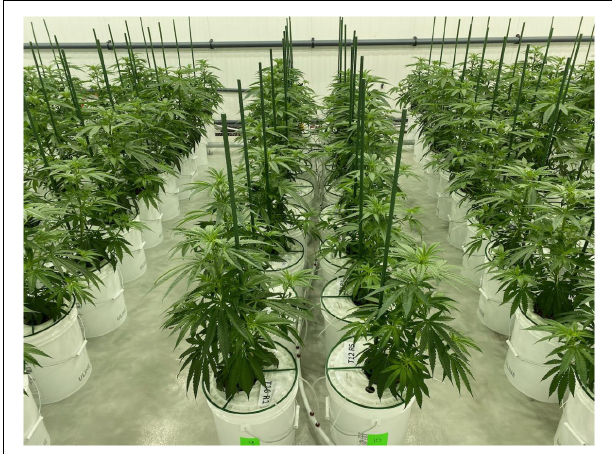
FIGURE 1 | Rows of deep-water culture units containing trial plants at the end of the 3-week vegetative stage.